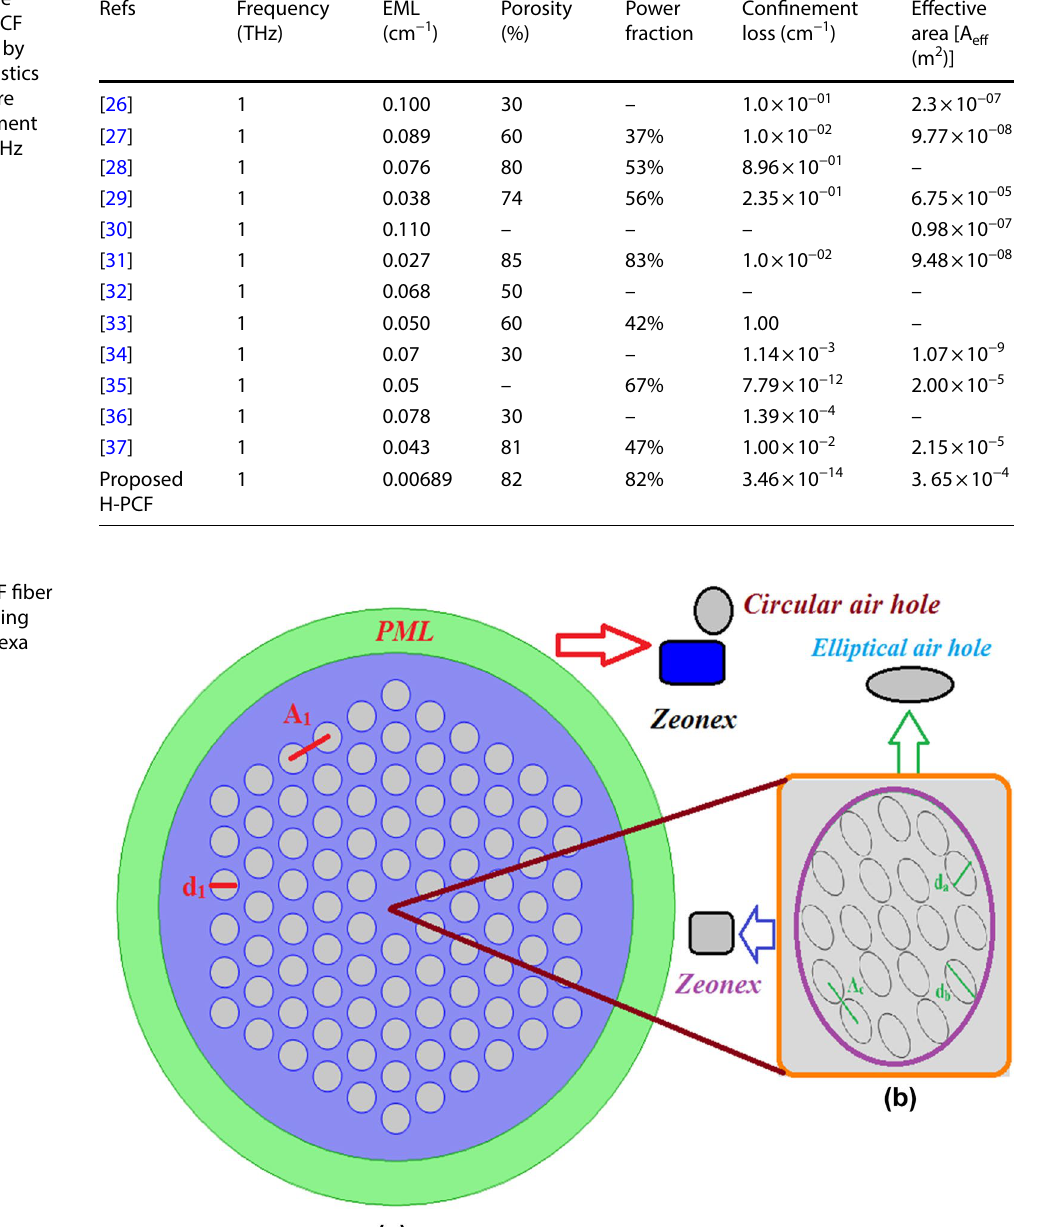
Table 1 Comparison table of previously proposed PCF and our proposed H-PCF by examining the characteristics of EML, core porosity, Core Power Fraction, Confinement Loss, Effective Area at 1 THz